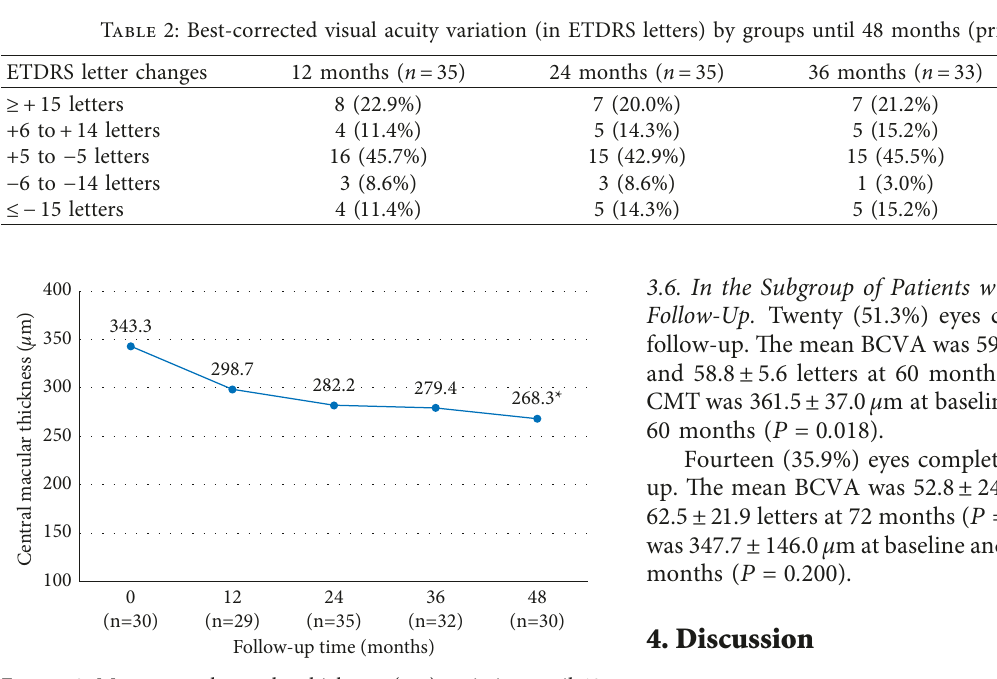
Figure 2: Mean central macular thickness ( μ m) variation until 48 months (primary